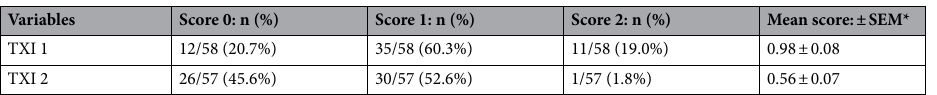
nosis, overall diagnostic accuracy from 3 trainees was significantly higher in both TXI1 and 2 compared to WL (Both P < 0.0001). We also assessed inter- observer agreement assessed by the Cohen’s kappa value in WL, TXI1 and 2 across three different trainees. WL presented moderate agreement with kappa values, 0.30–0.50, while TXI1 presented kappa values (0.00–0.03). The TXI2 presented slight to moderate agreement (0.21, 0.66) in two of three trainees but low in one trainee (Supplementary Table 2).